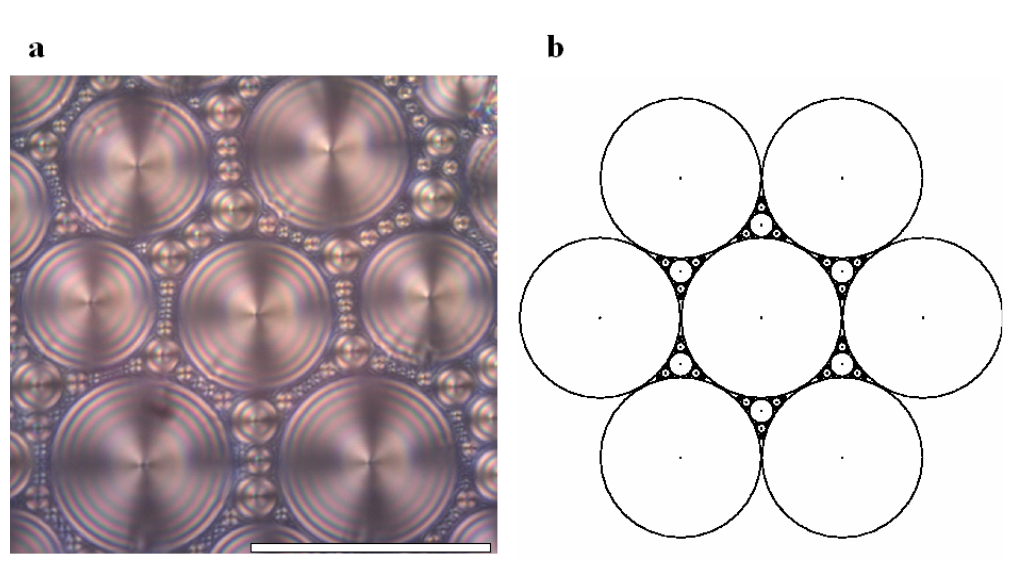
Figure 3. (a): experimental observation of some quasi-hexagonal tiling in 8CB, sample thickness ∼ 100 µm , bar ∼ 100 µm ; (b): Apollonius tiling of circles showing 4 generations of sizes using some C ++ numerical